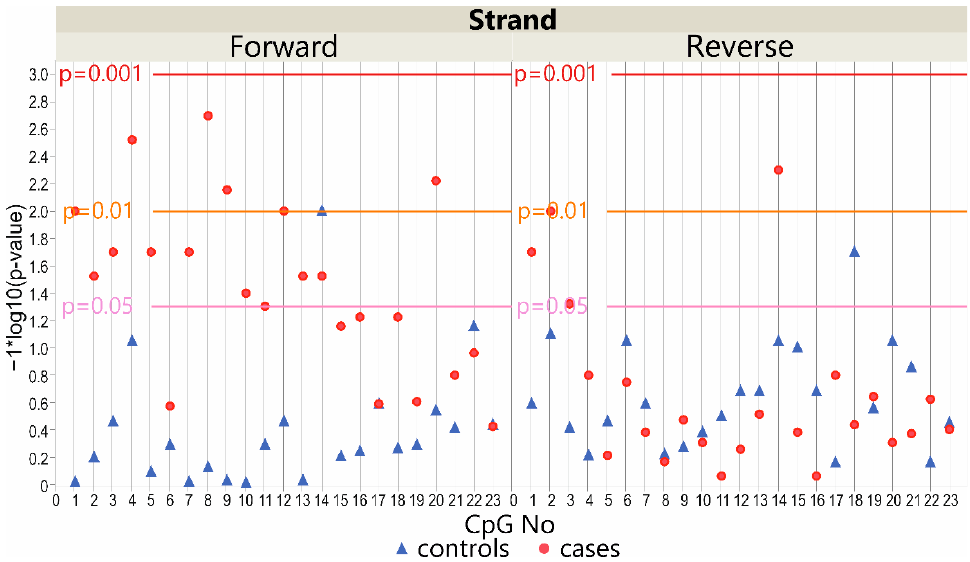
Figure 2. Scatter plot of − log10 p -values showing the difference between methylation level at LBX1 DNA forward strand (left) and DNA reverse strand (right) promoter CpG sites in cases and controls (convex vs. concave vs. superficial muscles). Reference horizontal lines represent the p -values.